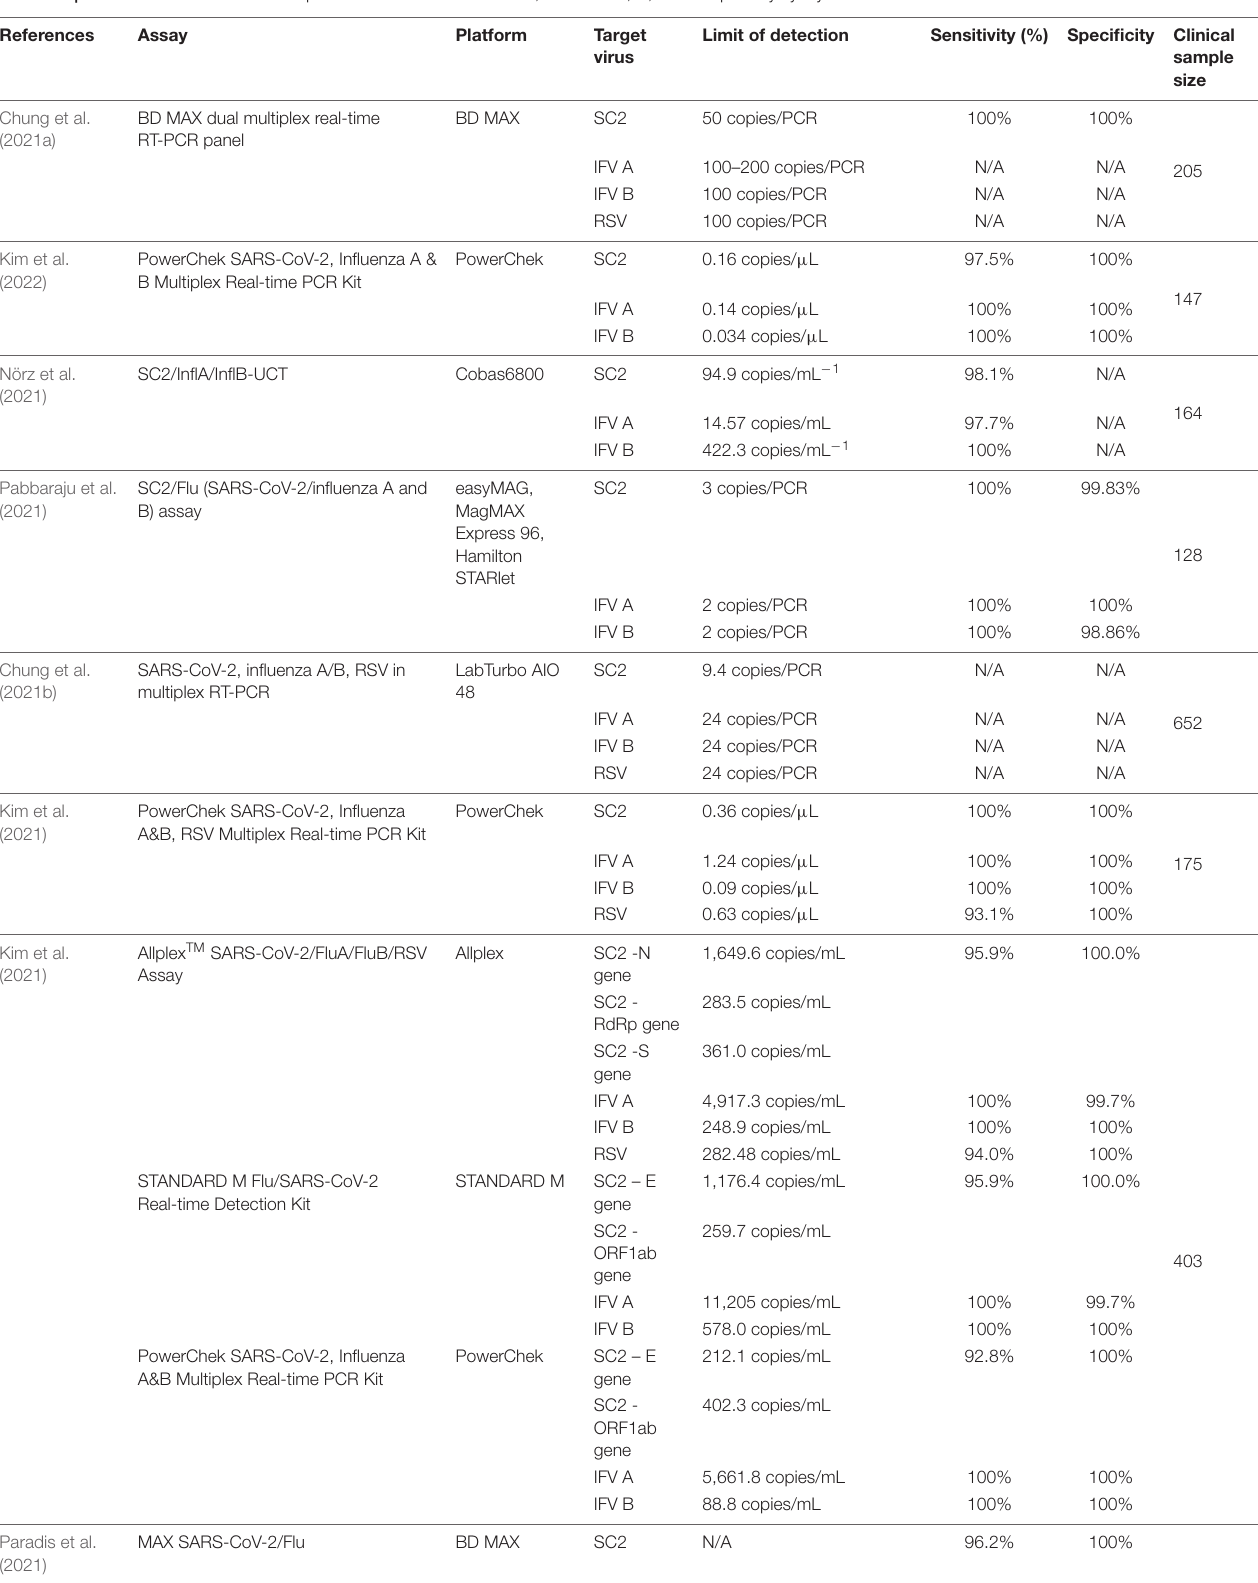
TABLE 1 | Data on current RT-PCR multiplex detection of SARS-CoV-2, Influenza A, B, and Respiratory syncytial